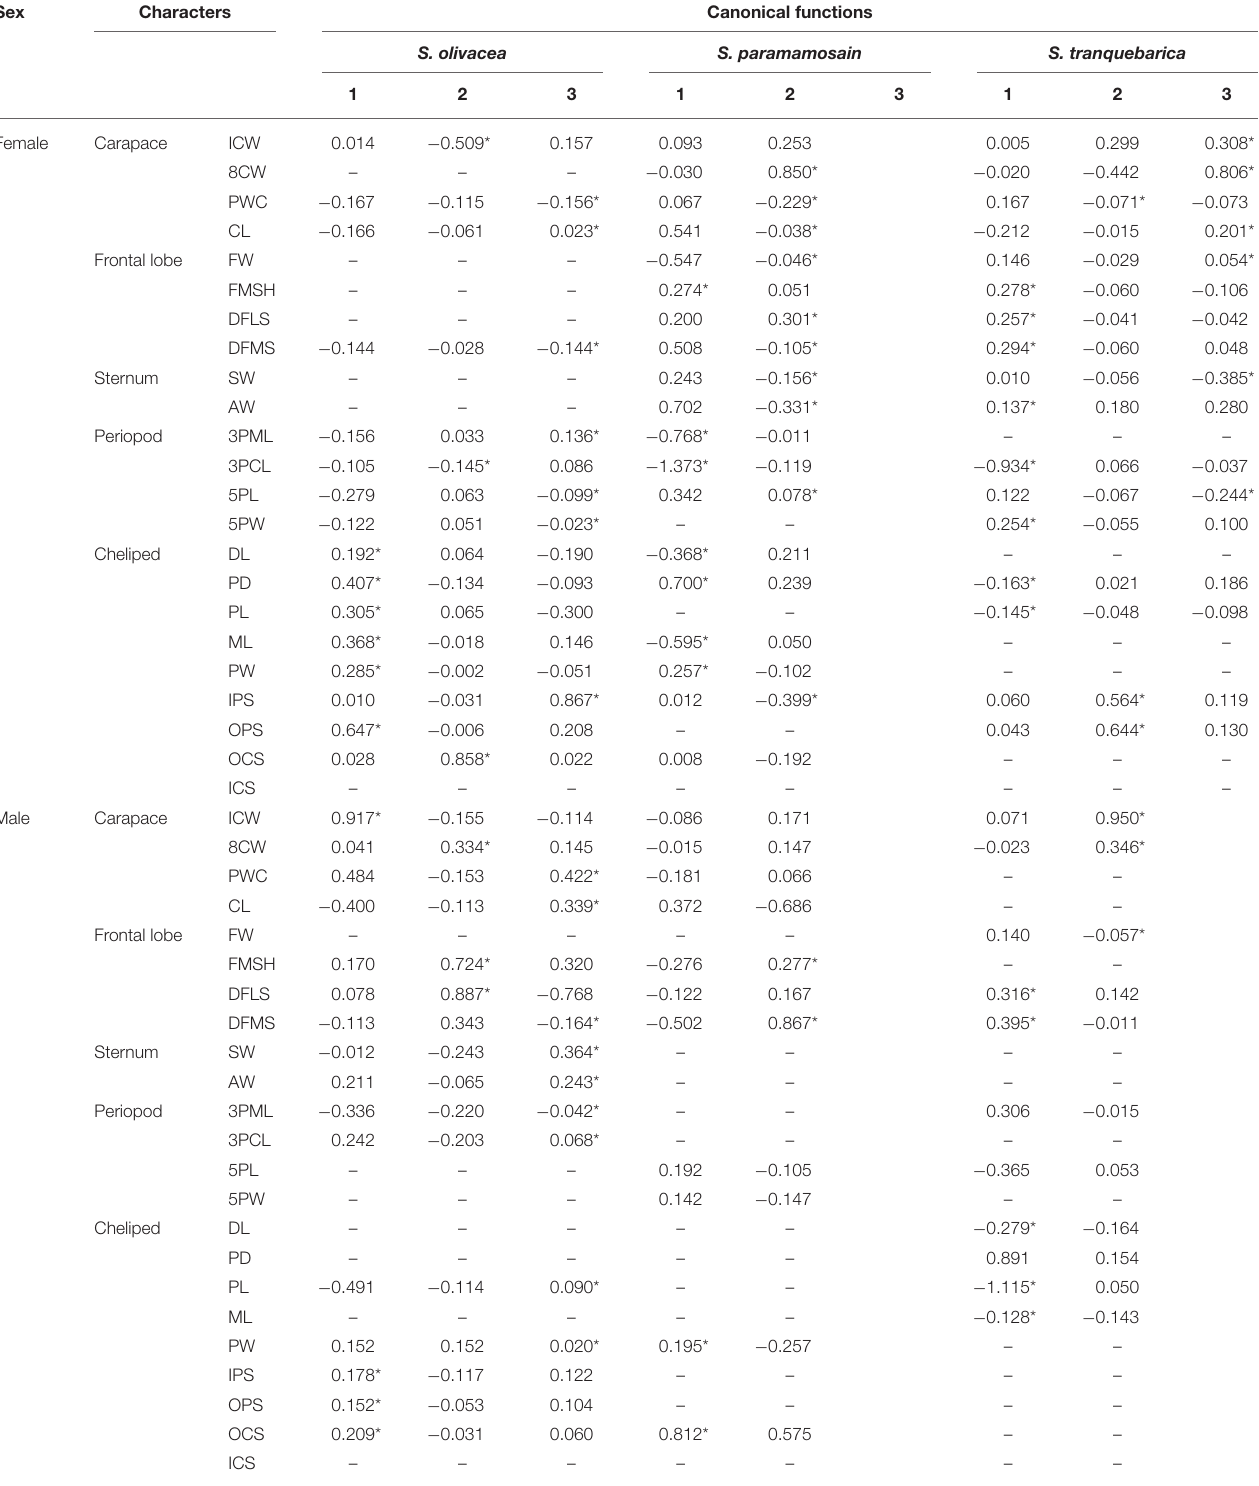
TABLE 1 | Standardized canonical discriminant function coefficients of Scylla